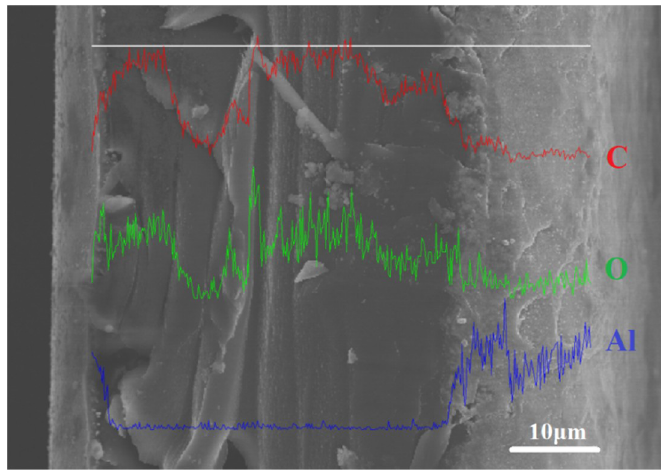
Figure 14. EDS line scanning image for cross-section of composite films.